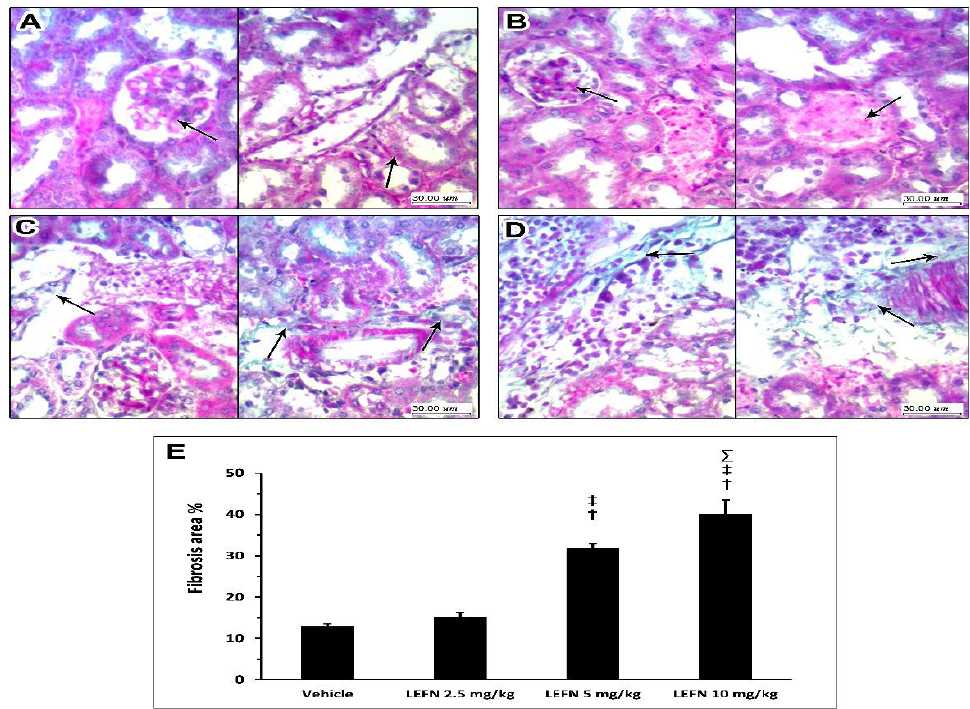
Figure 7. Masson’s trichrome staining for the kidneys of mice treated with LEFN. ( A , left panel) Sections in kidney tissue from the vehicle group showing glomerulus and proximal tubules with interstitial tissue showing no deposition of green staining fibers in between, and no fibrosis. ( A , right panel) shows distal tubules and a vessel in the center with no perivascular or peritubular collagen deposition (arrow). Sections from the kidneys of the LEFN 2.5 mg/kg group showing ( B , left panel) no glomerular deposition of collagen fibers (arrow) ( B , right panel) shows areas of congested vessels (arrow) with no or faint perivascular green staining, indicating no fibrosis from the kidneys of the LEFN 2.5 mg/kg group. ( C , left panel) Sections in kidney tissues from the LEFN 5 mg/kg group showing peritubular and interstitial mild focal deposition of thin green staining collagen fibers (arrow). ( C , right panel) shows areas of perivascular, green-stained collagen fibers deposition (arrow), indicating more localization to perivascular areas in the kidneys of the LEFN 5 mg/kg group. ( D , left panel) Sections in kidney tissue from the LEFN 10 mg/kg group showing peritubular and interstitial inflammatory infiltrate with deposition of thin green staining collagen fibers (arrow). ( D , right panel) shows wider areas of perivascular, green-stained collagen fibers deposition (arrow), indicating more localization to perivascular areas from the kidneys of the LEFN 10 mg/kg group. ( E ) Column chart for the mean ± SD of the fibrosis area % as measured in each group kidney sepecimens. †: versus the vehicle group, ‡: versus the LEFN 2.5 mg/kg group, and Σ: versus LEFN the 5 mg/kg group at p < 0.05.